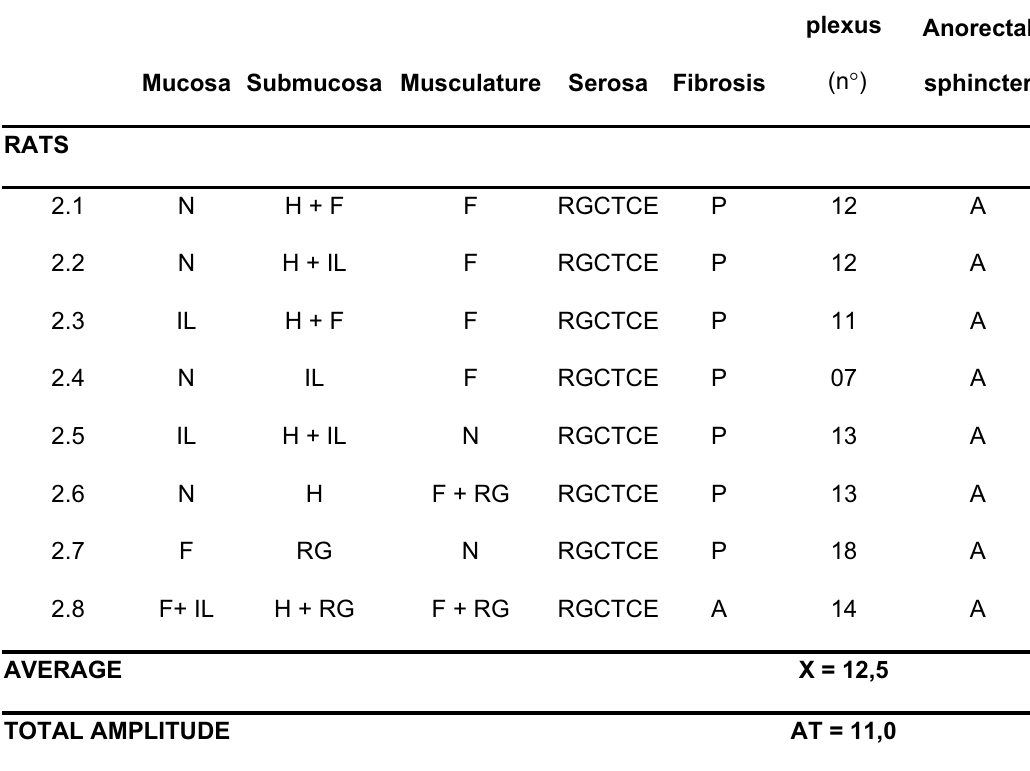
TABLE 2 – Histology of Intestinal Segments – RATS